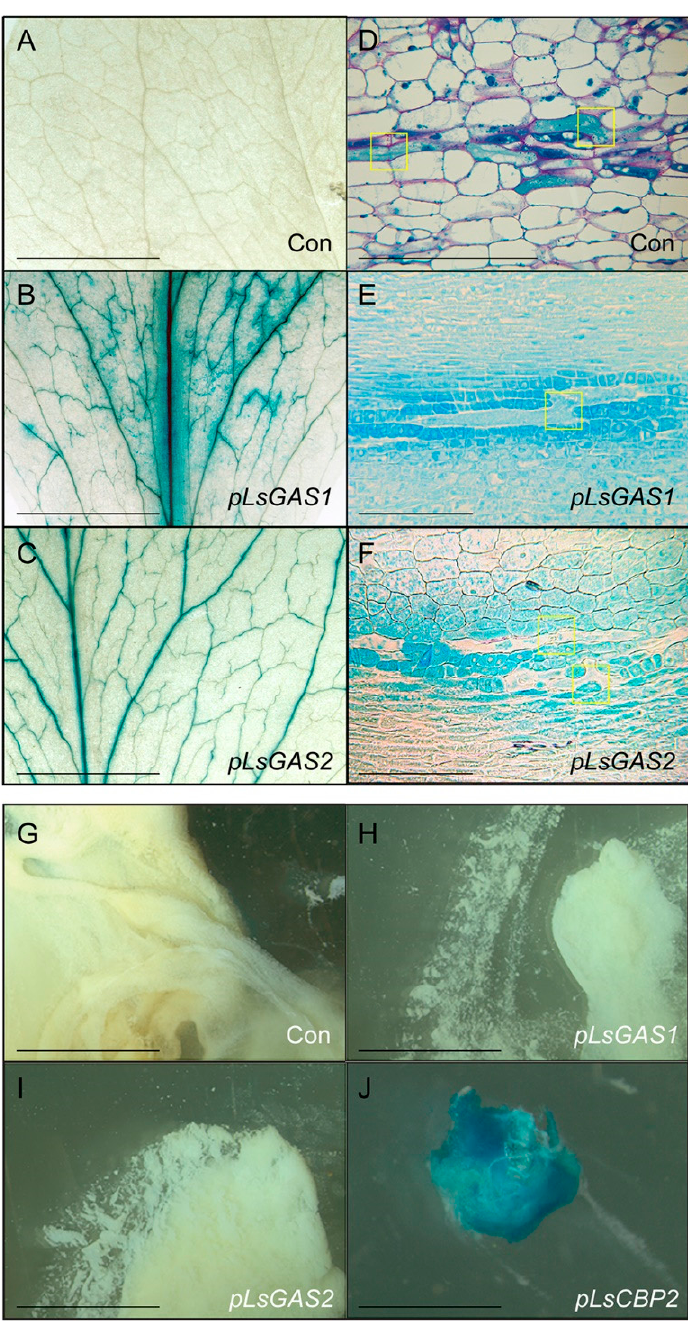
Figure 3. LsGAS1 and LsGAS2 promoter analyses in transgenic lettuce. ( A–C ). In situ GUS-staining patterns in leaves of transgenic lettuce. Scale bars are 5 mm. ( A ) Vector control (Con); ( B ) pLsGAS1- GUS -transformed lettuce; ( C ) pLsGAS2-GUS -transformed lettuce. ( D – F ) Microsections of stems at early bolting stage from wild-type control (Con) and transgenic lettuce ( pLsGAS1/2-GUS constructs). Scale bars are 20 µm. ( D ) The high density of proteins in laticifers were stained with amido black 10B, and total carbohydrates were stained with periodic acid-Schiff’s (PAS) stain in vector control lettuce. Yellow rectangles show characteristic features of cell fusions in laticifers. ( E , F ) GUS activities are visualized by blue pigment. Laticifers with cell-fusions (indicated by yellow rectangles) are shown as negative images in blue backgrounds. ( G–J ) GUS activity assays using isolated latex. Previously reported transgenic lettuce ( pLsCBP2-GUS ) was used as a positive control [13], and vector control was used as a negative control (Con). Scale bars are 5 mm.